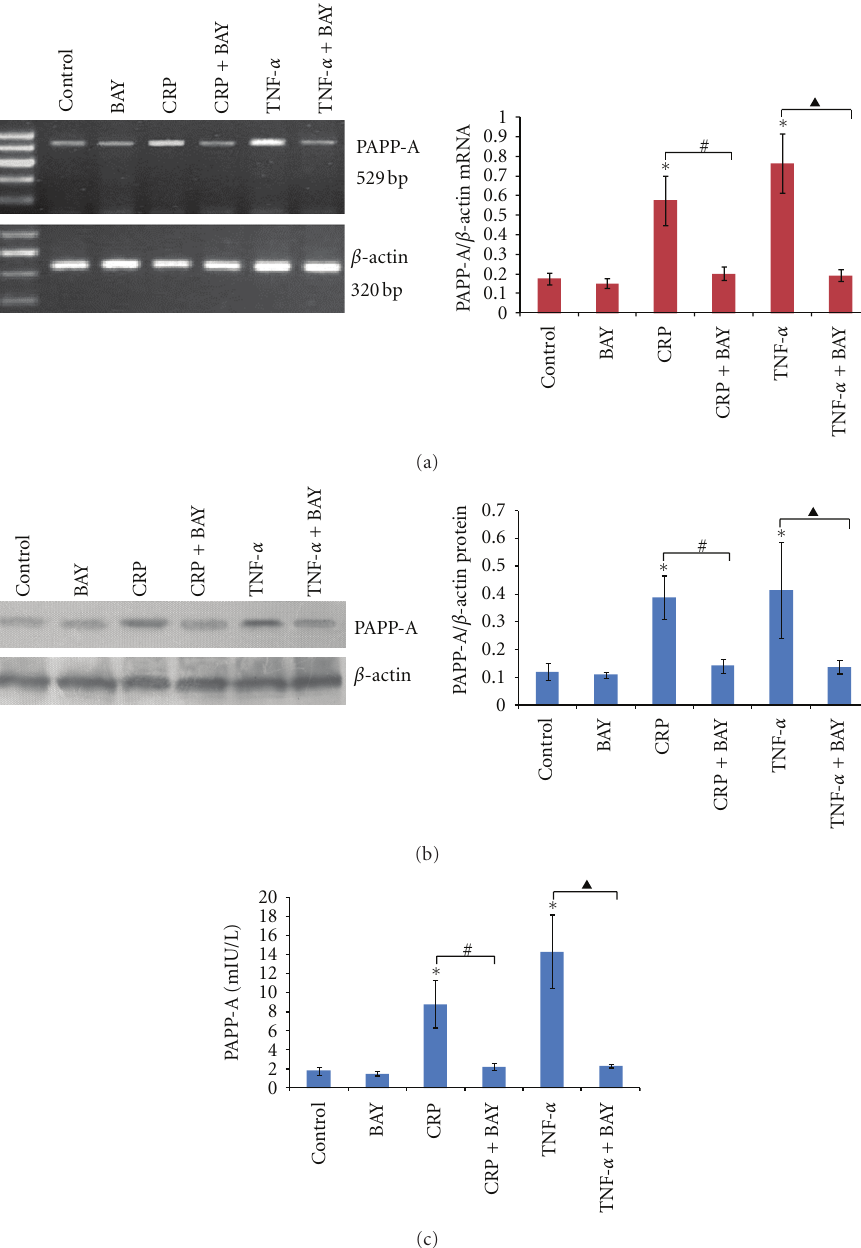
Figure 4: E ff ect of BAY11-7082 on cytokine-induced PAPP-A expression. PBMCs were pretreated with BAY11-7082 (20 μ M) for 60min and then treated with CRP (20mg/L) or TNF- α (100ng/mL) for 24 hours. (a) Detection of PAPP-A mRNA expression was conducted by RT- PCR. (b) PAPP-A protein expression were determined by Western blotting. (c) PAPP-A concentrations were performed by an ultra-sensitive ELISA. The results are expressed as the means ± SD of six donors. ∗ : P < 0 . 05 compared with the control; #: P < 0 . 05 the CRP group versus the CRP + BAY group; (cid:2) : P < 0 . 05 the TNF- α group versus the TNF- α + BAY